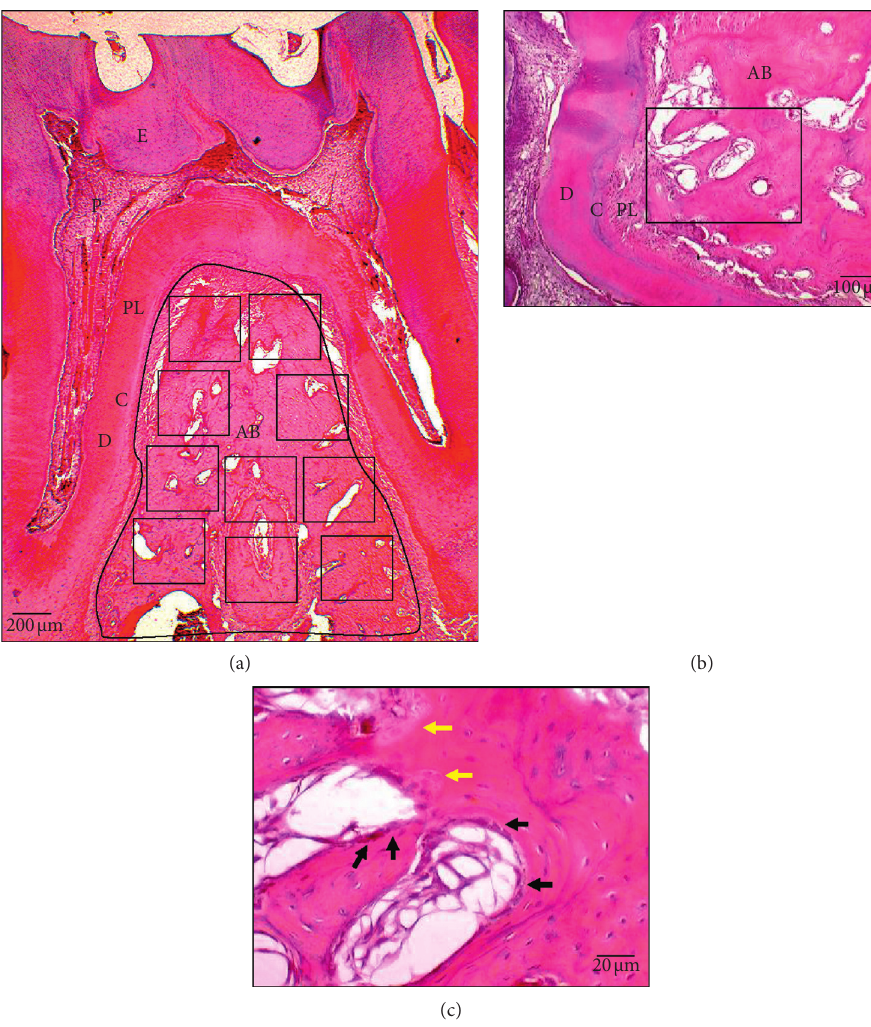
Figure 3: Alveolar bone histological analysis area. (a) The cell number of osteoclasts and osteoblasts cell number were counted at bone remodeling areas 10hpf (high-power fields) at 4x magnification within the interradicular bone of first molar, represented by the black line. AB, alveolar bone; E, enamel; D, dentine; P, pulp; C, cementum; PL, periodontal ligament. (b) Example of one of the field areas for histological analysis (represented by the black line) at 10x magnification. (c) Quantitation of osteoblasts and osteoclasts under 40x magnification. The mononuclear cell of osteoblasts was lined up the external surface of bone trabeculae and the surface of Haversian canals (represented by ). Large multinucleated cells of osteoclasts were located in small resorptive excavations (represented by